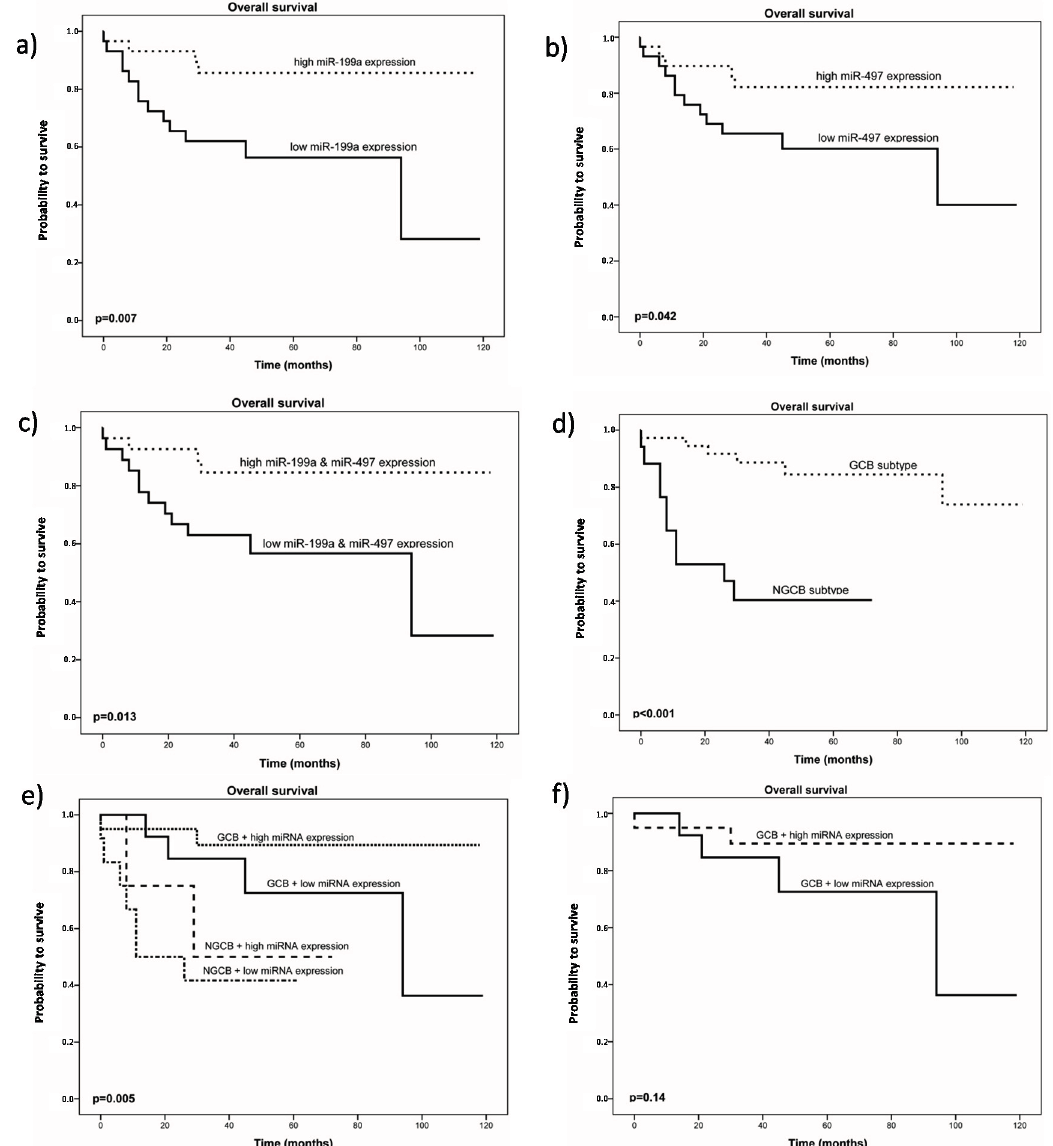
Figure 2. ( a ) Kaplan Meier plot for overall survival in patients with diffuse large B-cell lymphoma (DLBCL) ( n = 58) stratified by miR-199a expression level. The black dotted line represents patients with high miR-199a expression levels; ( b ) Kaplan Meier plot for overall survival in patients with DLBCL ( n = 58) stratified by miR-497 expression level. The black dotted line represents patients with high miR-497 expression levels; ( c ) Kaplan Meier plot for overall survival in patients with DLBCL ( n = 58) stratified by miR-199a and miR-497 expression levels. The black dotted line represents patients with high miR-199a and high miR-497 expression levels; ( d ) Kaplan Meier plot for overall survival in patients with DLBCL ( n = 55) stratified by their Immunohistochemistry (IHC) profile; ( e ) Kaplan Meier plot for overall survival in patients with DLBCL ( n = 58) stratified by their IHC profile combined with miR-199a and miR-497 expression levels; ( f ) Kaplan Meier plot for overall survival in patients with DLBCL, germinal center subtype (GCB) ( n = 38) stratified by miR-199a and miR-497 expression level. The black dotted line represents patients with high miR-199a and miR-497 expression